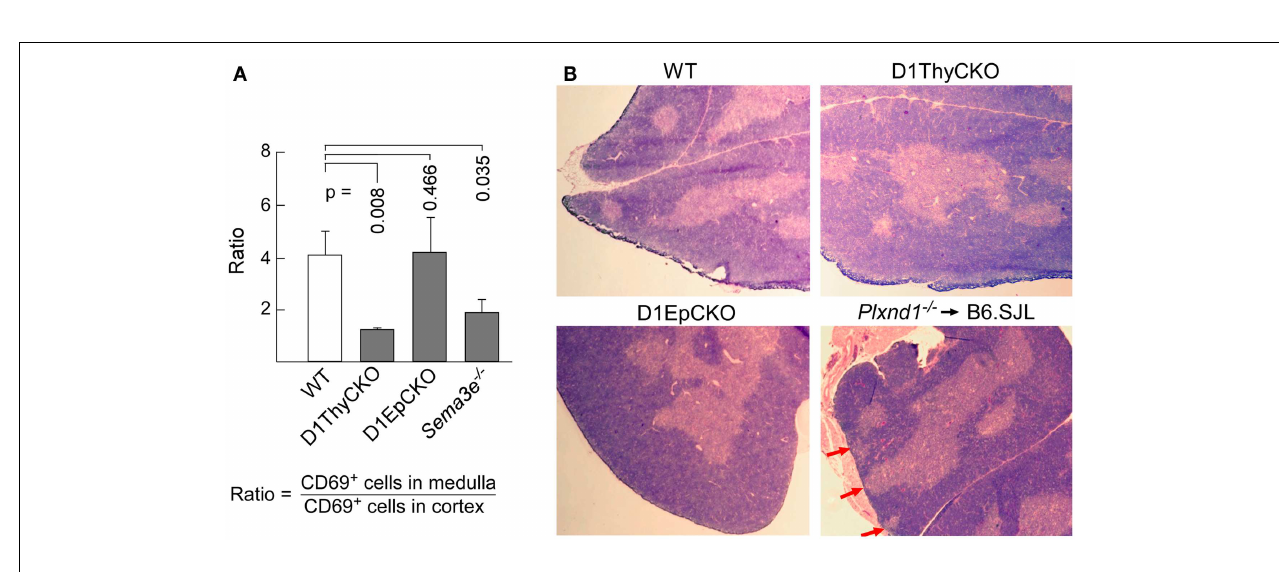
presence on comparison with cortex. Error bars represent SEM. (B) Medullary structures were visualized by hematoxylin and eosin (H&E) staining ofWT, D1ThyCKO, and D1EpCKO thymi as well as in thymus in irradiated animals repopulated with Plxnd1 − / − fetal liver.The red arrows in the Plxnd1 − / − section indicate regions of fused thymic medulla and capsule. Each figure is representative of three independent experiments.